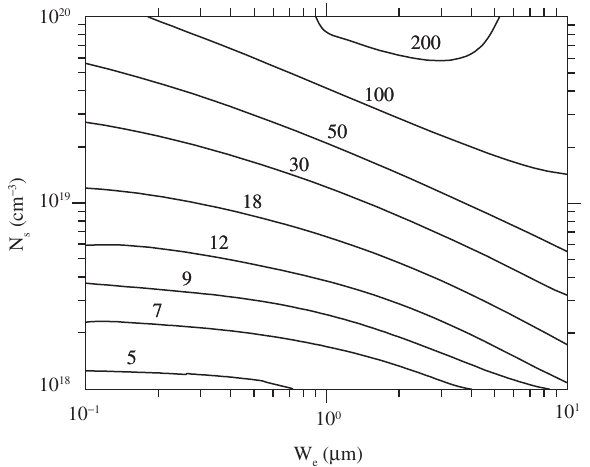
(fA.cm –2 ) as a oepass and thickness, W for both types: s e = N x 10 –16 cm/s). p s